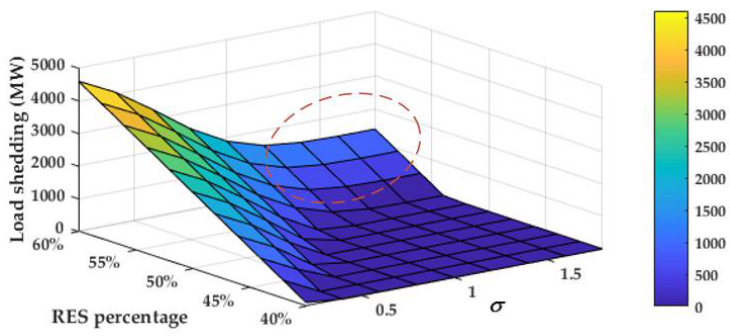
Figure 12. Impact of DR percentage and σ on load